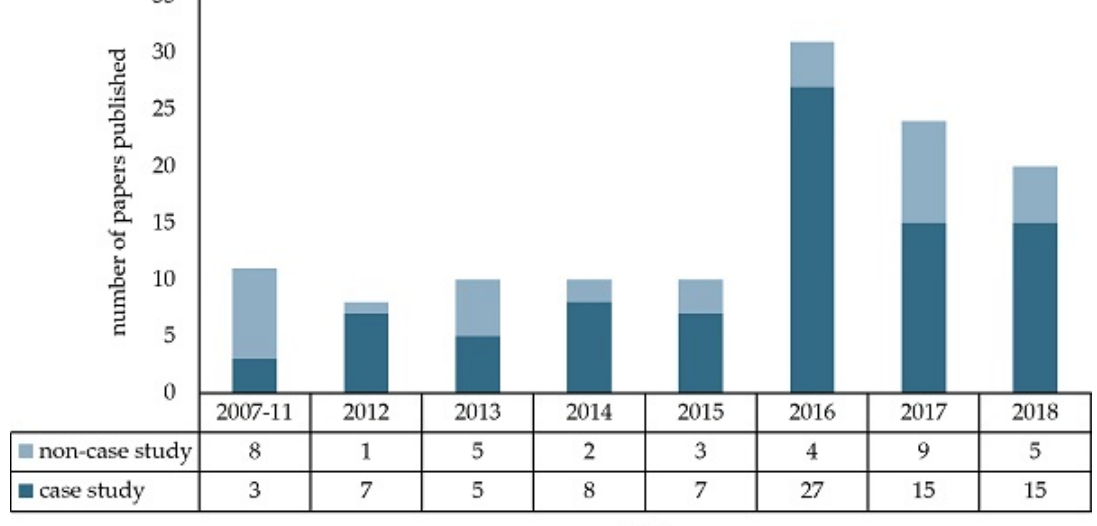
Figure 3. LCSA-related papers published from 2007 to October 2018 [24].